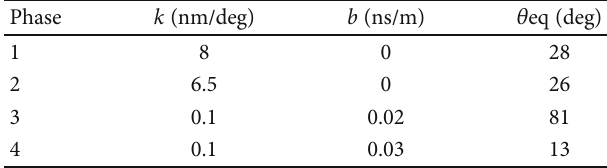
Figure 15: Result of the FE analysis of the lower-limb structure. Table 5: Coe ffi cient of controller for stair descent.